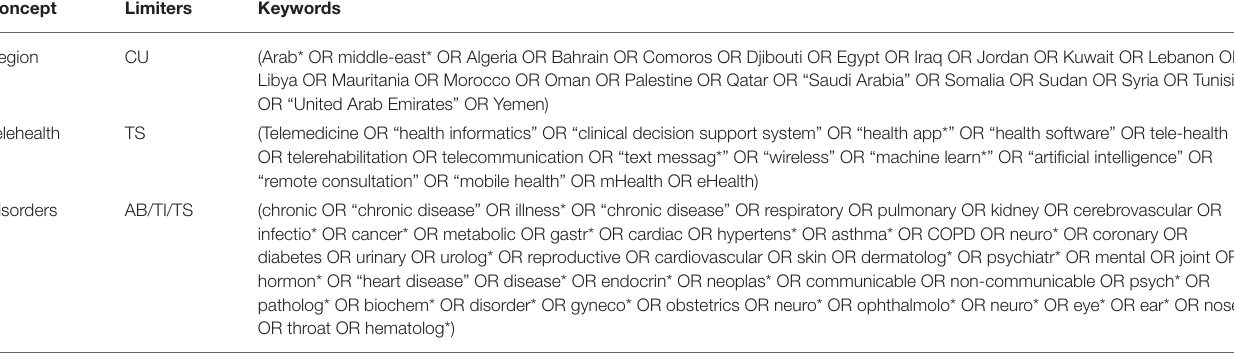
TABLE 1 | Search strategy for Web of Science (core database)